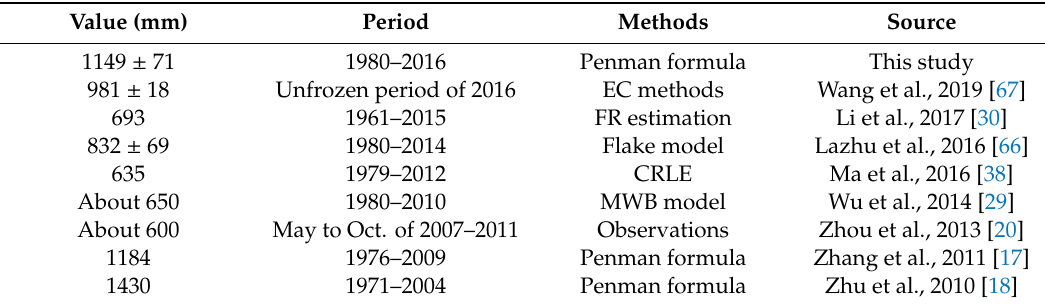
Table 3. Some surface evaporation estimates for Nam